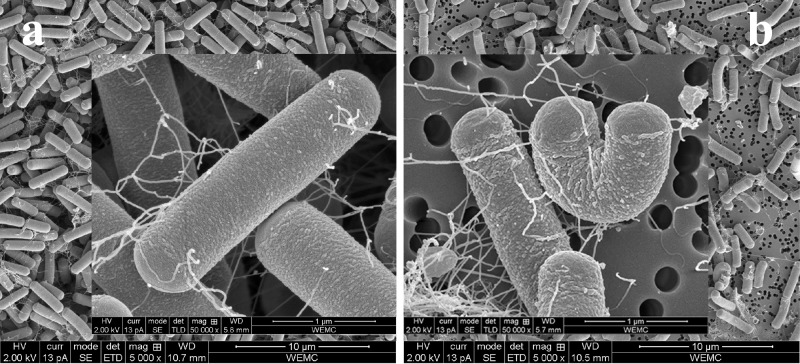
Cells of the WT and its ΔrpoN mutant.SEM images of aerobically grown overnight cultures of B. cereus ATCC 14579 WT (a) and its ΔrpoN mutant derivative (b) in BHI at 30°C.